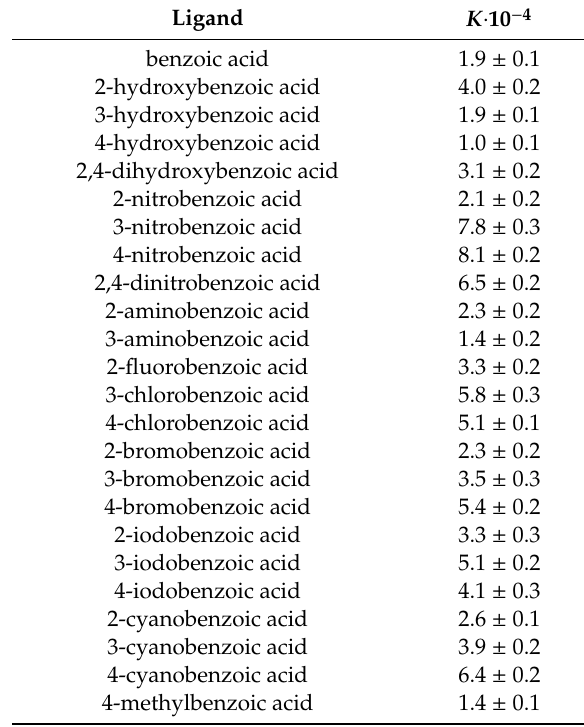
Table 1. Measured values of the binding constants of substituted benzoic acids with bovine serum albumin (BSA) at 298